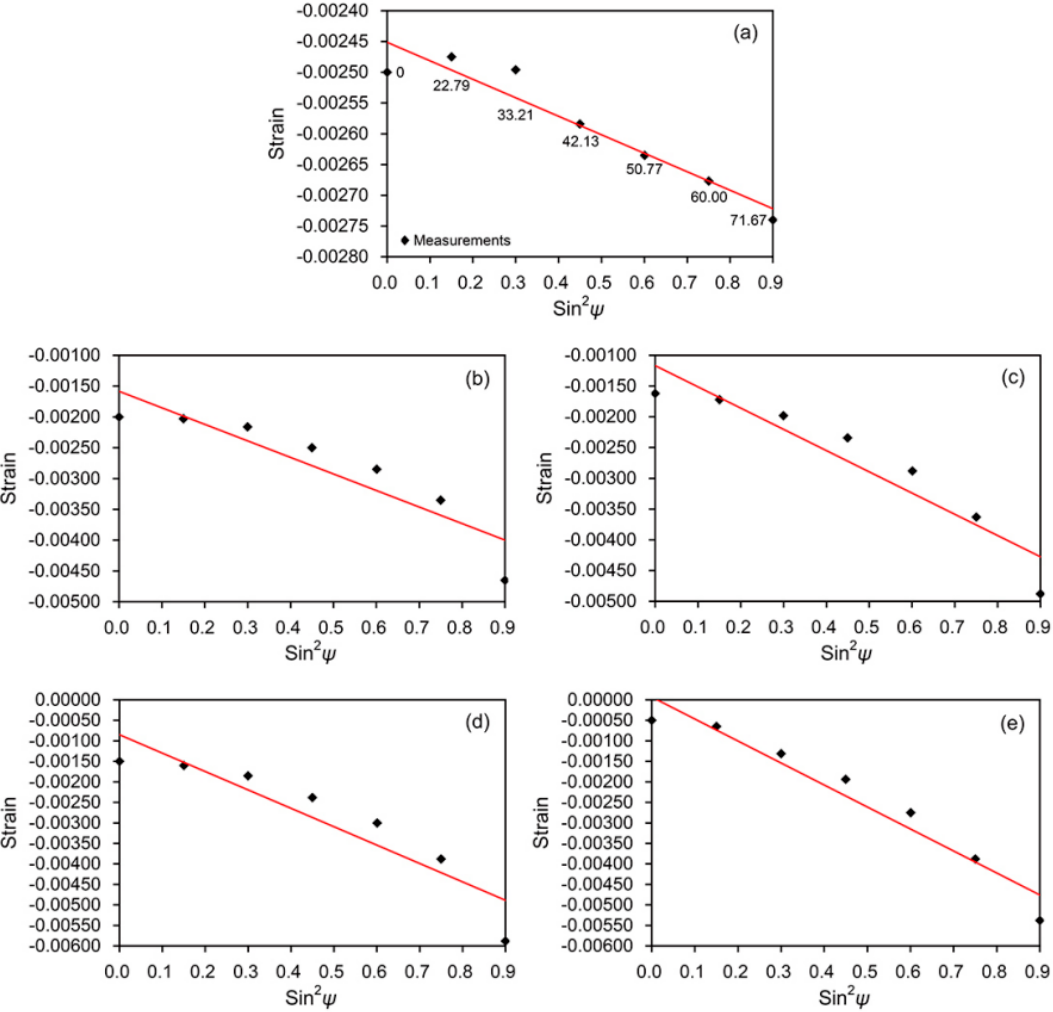
Figure 4. Linear dependence of the lattice strain (002) on sin 2 ψ for the polished ( a ) and sandblasted